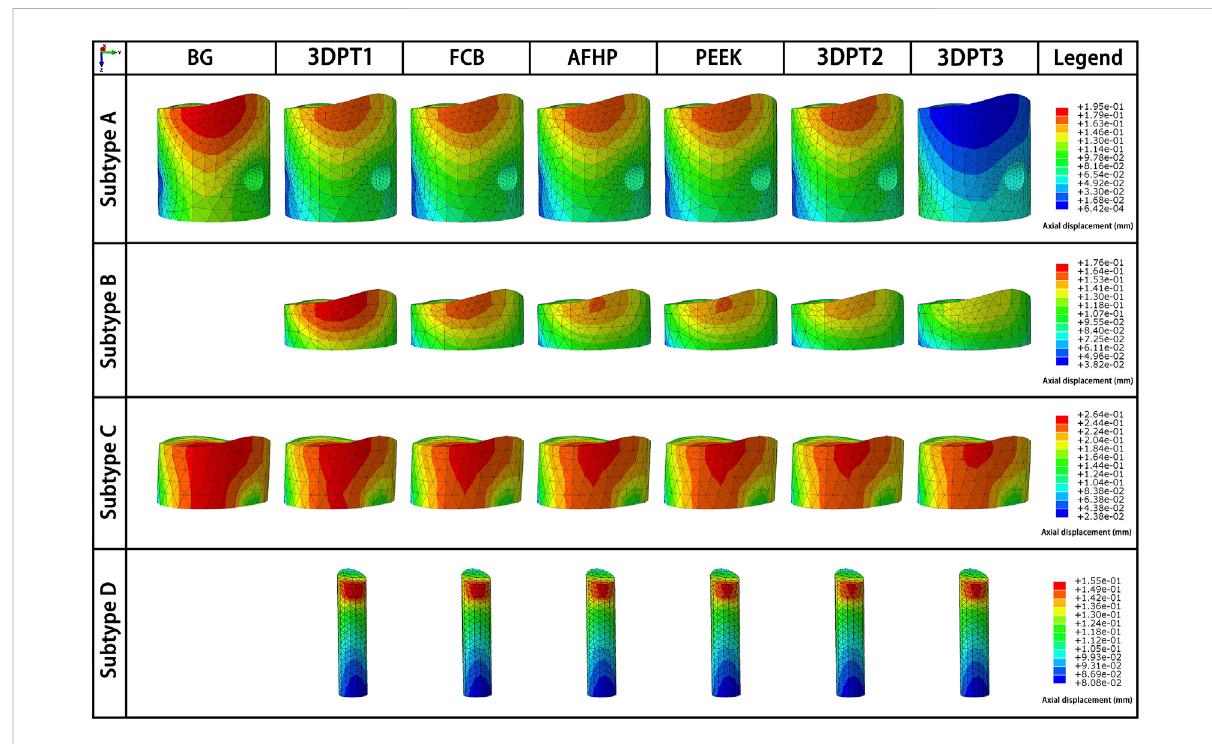
FIGURE 6 Directional displacement fi elds of the depressed fragment from the perspective of maximum displacement of the corresponding